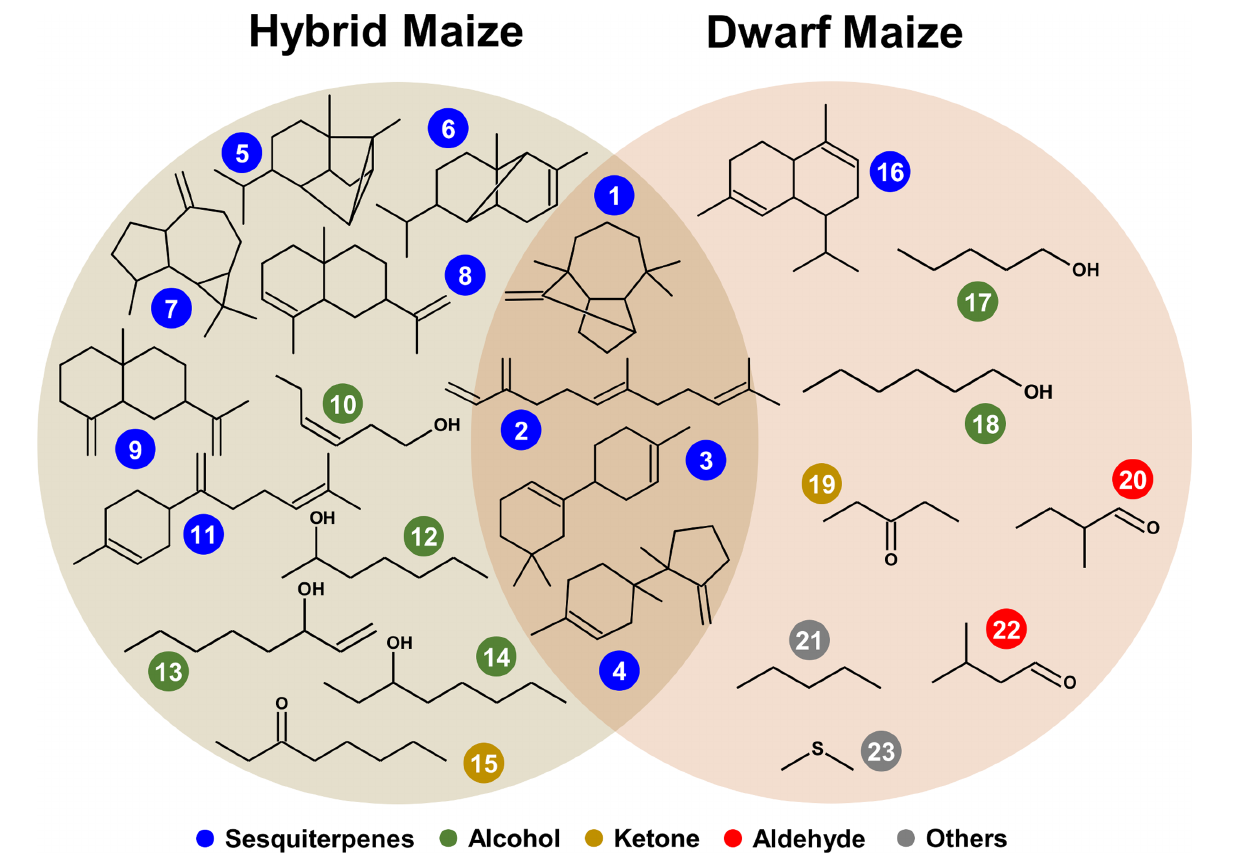
FIGURE 4 | Structures of common and specific infection biomarkers in hybrid and dwarf maize. Color coder represent chemical classes: (1) ( + )-longifolene, (2) β -farnesene, (3) β -macrocarpene, (4) trichodiene, (5) ( + )-cycloisosativene, (6) α -ylangene, (7) ( + )-aromadendrene, (8) α -selinene, (9) β -selinene, (10) 3-hexen-1-ol, (11) β -bisabolene, (12) heptan-2-ol, (13) 1-octen-3-ol, (14) octan-3-ol, (15) octan-3-one, (16) α -muurolene, (17) pentan-1-ol, (18) hexan-1-ol, (19) pentan-3-one, (20) 2-methyl-butanal, (21) pentane, (22) 3-methyl-butanal, (23) dimethyl